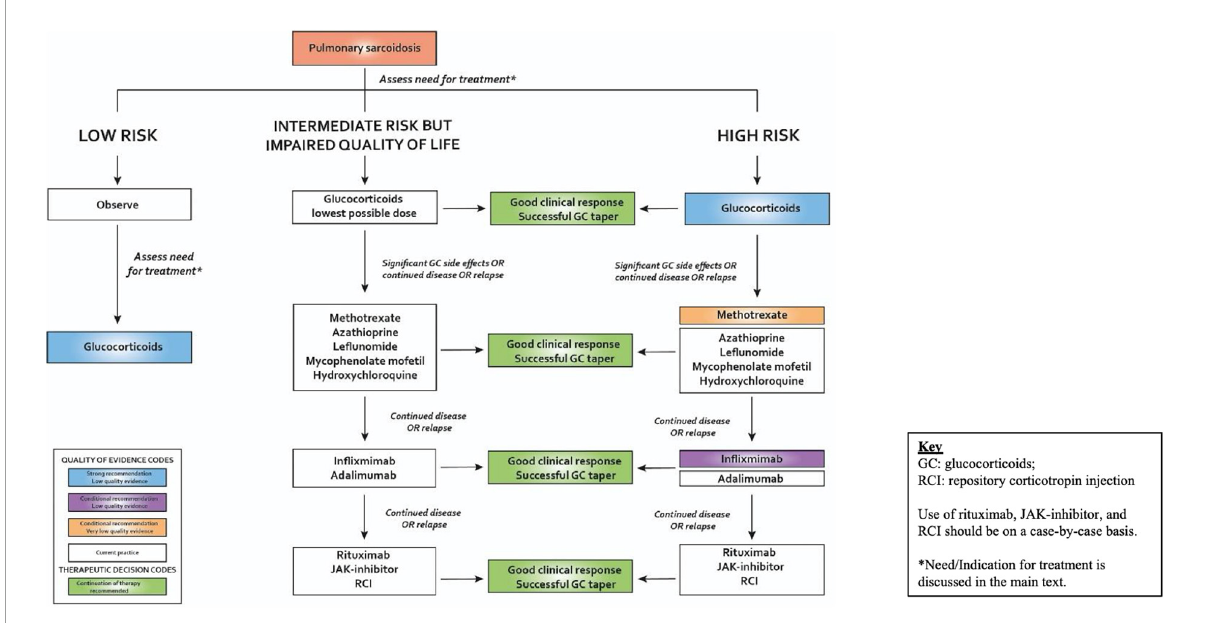
FIGURE1 Approach to management of plumonary sarcoidosis. Reproduced with permission from the European Respiratory Society (ERS) clinical practice guidelines on the treatment of sarcoidosis (5). All rights